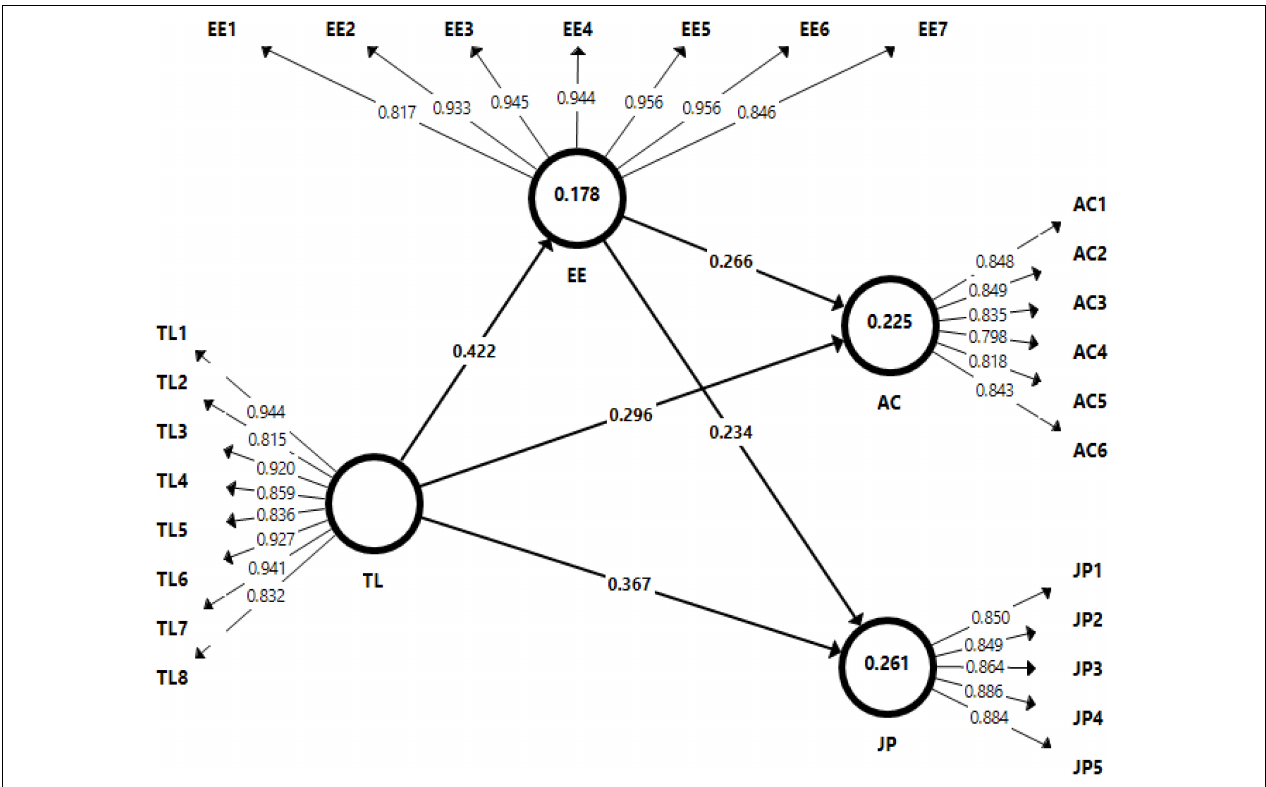
FIGURE 2 | Measurement model.